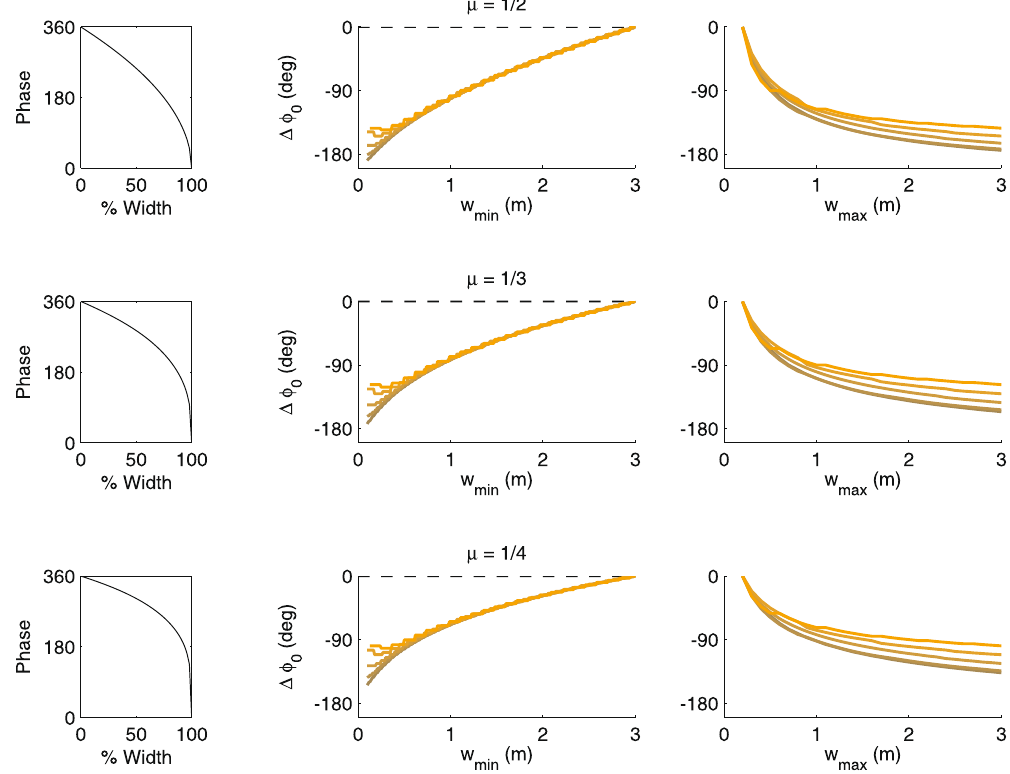
Figure 4. Nonlinear phase precession. (Left column) Non-linear models of phase precession with increasing curvature from top to bottom. (Middle) Optimal phase range for fixed maximal width and f = 1 (as in Fig. 2D). The different colors indicate different running speeds from 0.1 m/s (dark) to 1.2 m/s (bright). (Right) Optimal phase range for fixed minimal field width (as in Fig.